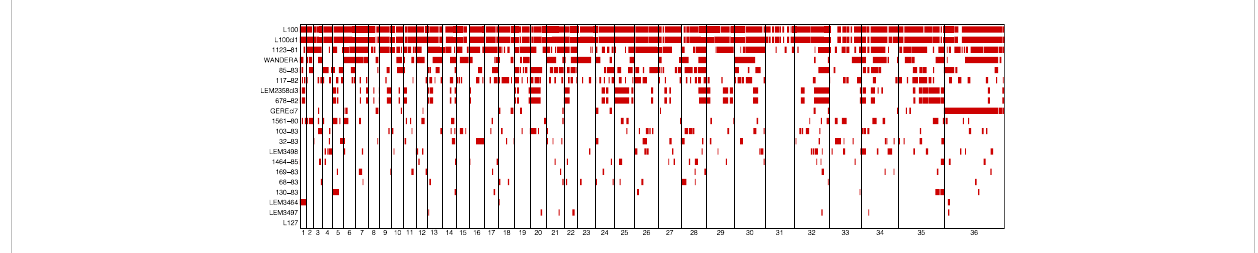
FIGURE 2 Loss-Of-Heterozygosity regions (red bars) in each of the 20 L. aethiopica genomes across the 36 chromosomes.